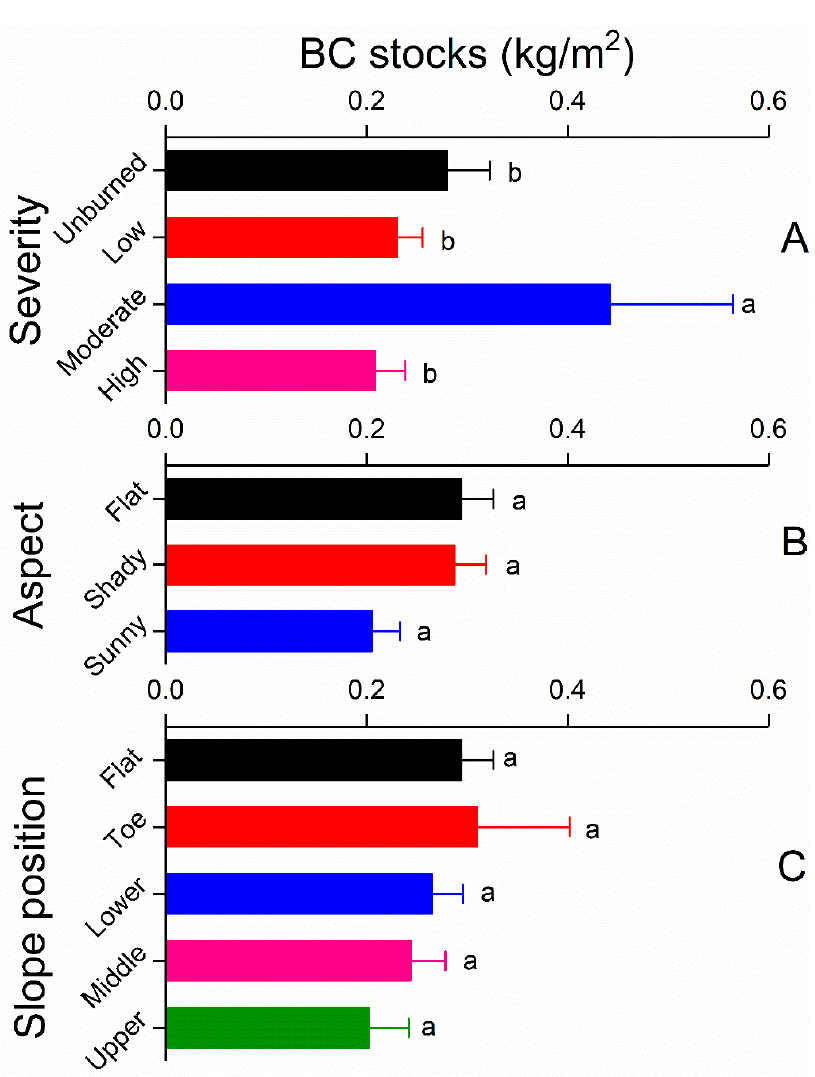
Figure 5. Soil BC stocks of various fire severities ( A ), on different aspects ( B ) and on different slope positions ( C ) in the Great Khingan Mountains. Error bars indicate standard errors.